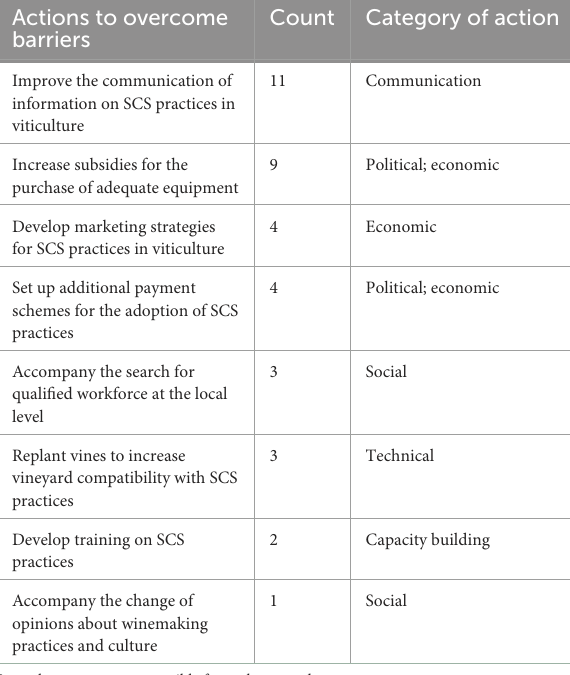
TABLE 1 Actions proposed by winegrowers to overcome the barriers to the adoption of soil carbon sequestration (SCS) practices ( n = 30). Actions to overcome barriers